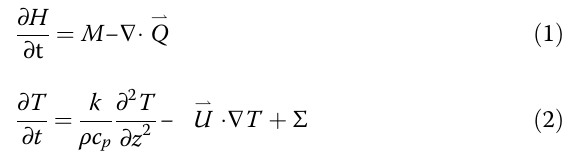
Table 1 Pavonis ridge statistics Extracted from CTX stereo DEM